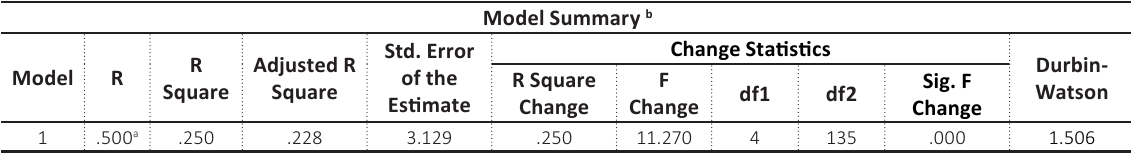
Table 5. Model summary of regression analysis between turnover intention, job stress, job satisfaction, work commitment, and organizational